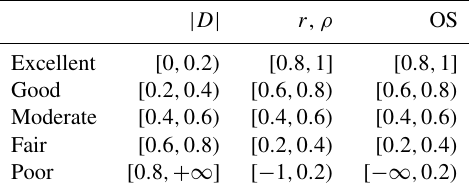
Table 4. Qualitative descriptions of intervals of the performance metrics to aid in interpreting the